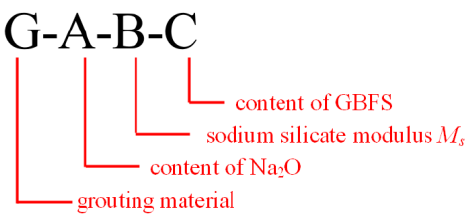
Figure 2. Nomenclature of grouting materials. Table 2. Mix proportions for FA-based geopolymer grouting materials.